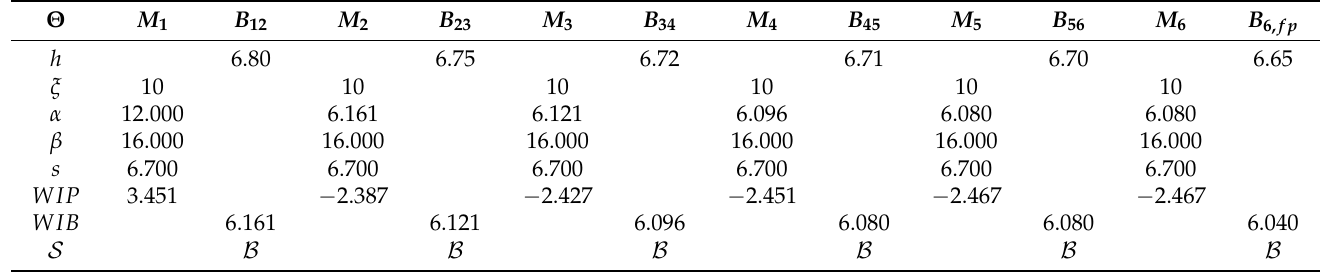
Table 4. Average values for the homogeneous birth–death process for T = 100